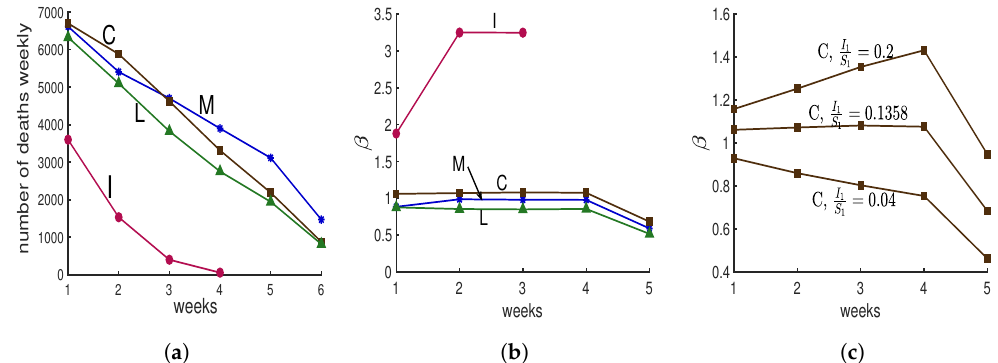
Figure 4. Four simulations from The New York Times. Panel ( a ) Following the beginning of the lockdown in New York City, The New York Times [10] reported on four simulations of deaths with projections for 4 to 6 weeks, shown here with weekly totals. The simulations included large uncertainty intervals that are not shown here. Write D n for deaths in week n . Panel ( b ) Contact rates β n . We assume that deaths are a constant fraction of actual cases, so D n + 1 / D n = I n + 1 / I n . Hence, if one has the initial fraction, I 1 , of susceptibles who are infectious and the contact rates β n , then Model E+ will exactly reproduce the curves in panel (a). See the text for a description of the computation of β and the values for I 1 s. Panel ( c ) Here three different choices for ratio I 1 / S 1 , for the case “C” are represented. As the figure represents only when I 1 / S 1 = 0.1358, the contact rate β will be constant during the middle of the